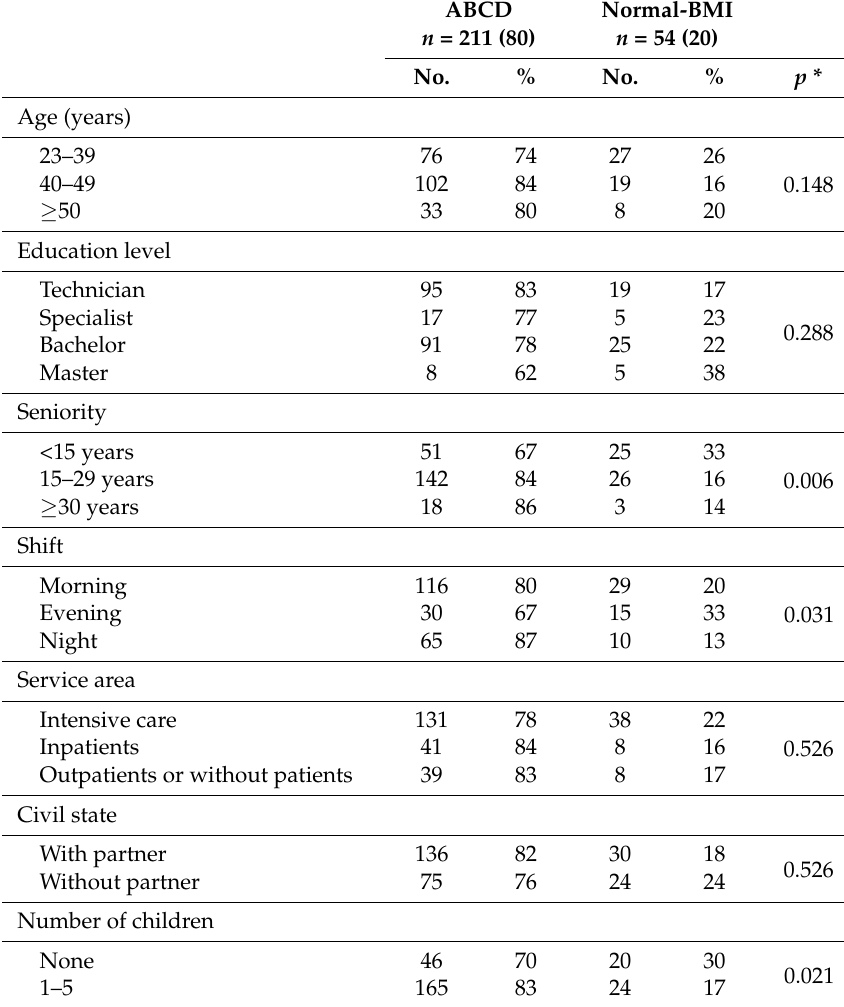
Table 1. Demographic characteristics in ABCD vs. normal